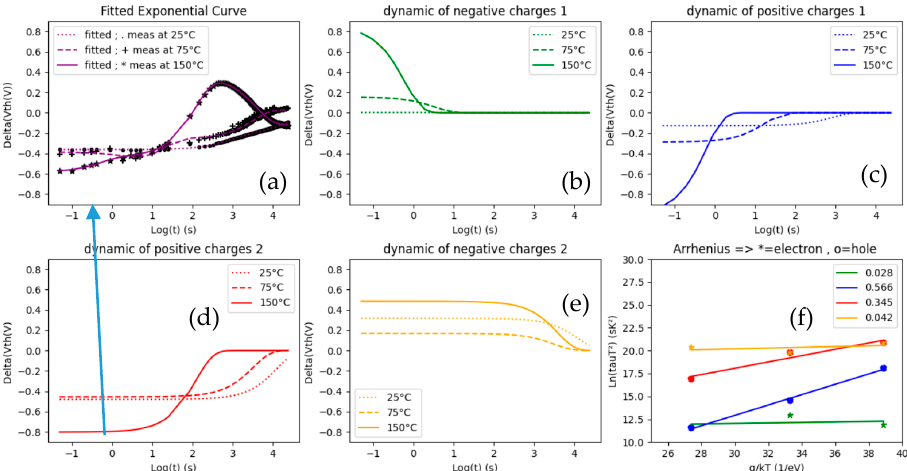
Figure 7. Design A wafer 2; ( a ) measurement at 25, 75 and 150 °C; ( b ) extraction of dynamic first level of negative charges; ( c ) extraction of dynamic first level of positive charges; ( d ) extraction of dynamic second level of negative charges; ( e ) extraction of dynamic second level of positive charges; ( f ) report of the four levels of charge in an Arrhenius graph (extraction of energy levels). Subfigures ( a – e ), show the Vth shift due to one trap level in function of time measured at 25, 75 and 150 °C. Subfigure ( f ) is the extraction of traps energies levels for each trap level.